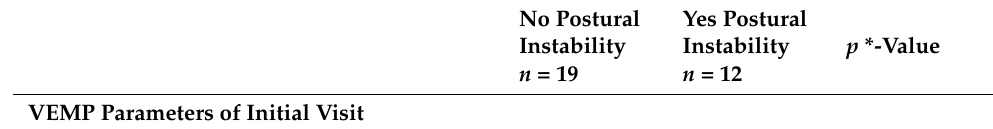
Table 2. Initial VEMP parameters of patients without postural instability and with postural